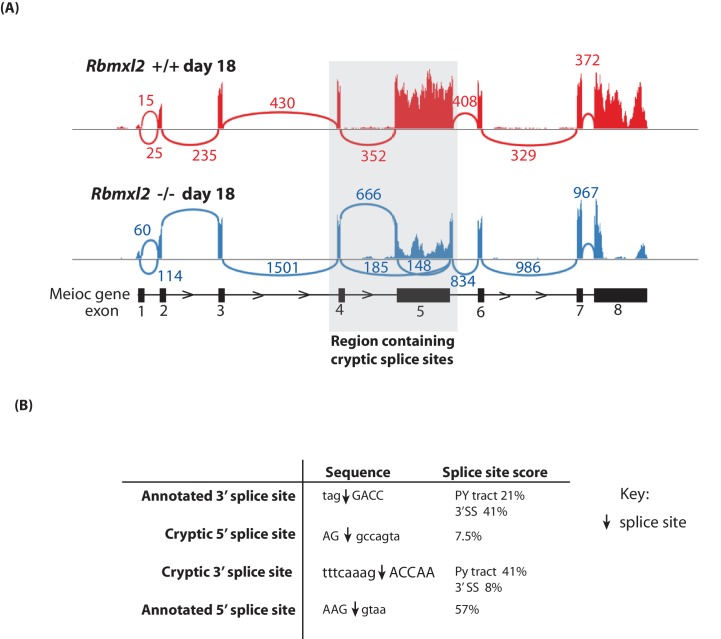
Further splicing analysis of the Meioc gene.(A) Sashimi plot showing exon junction reads across the Meioc gene. (B) Strengths of splice sites associated with Meioc exon 5. The actual splice sites are indicated in the sequences by downward facing arrows. Average annotated and cryptic splice site strengths were calculated using Sroogle (Schwartz et al., 2009).